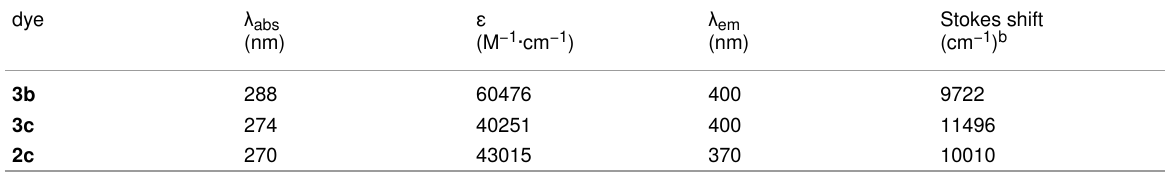
Table 1: UV–vis absorption and fluorescence data for 4-fluoroisoxazoles 3b and 3c , and non-fluorinated compound 2c a .